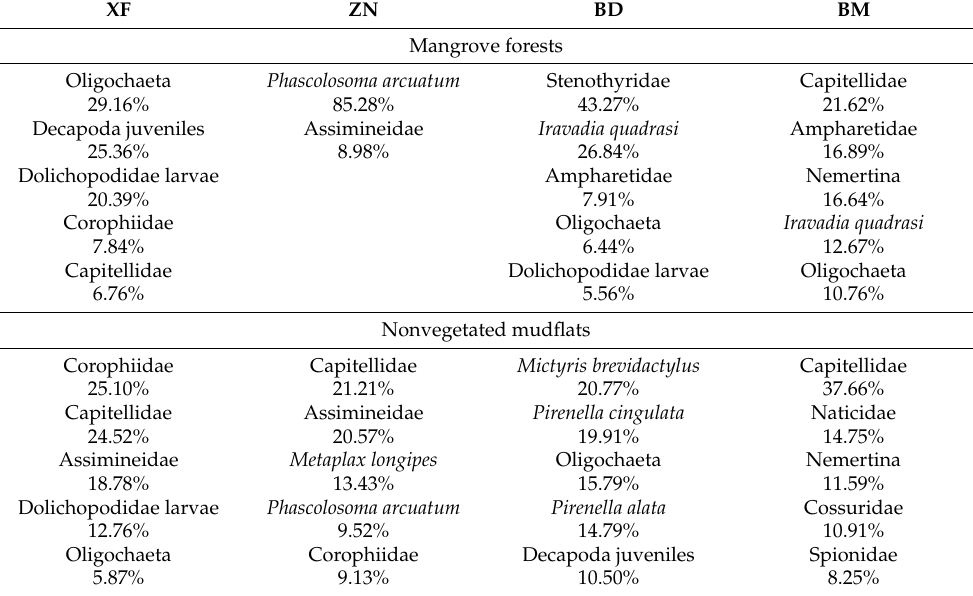
Table 2. SIMPER analysis of the macrobenthic communities collected from mangrove forests and nonvegetated mudflats on the western coast of Taiwan. The top 5 common and dominant taxa in each habitat were ranked by a contribution > 5% to the percentage similarity within each community.